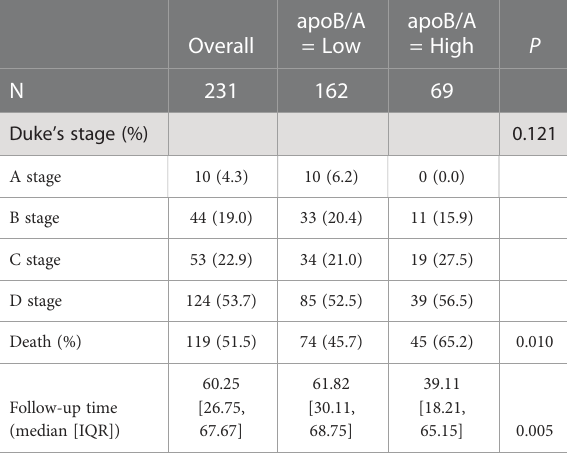
TABLE 1 Clinical baseline characteristics for enrolled colorectal